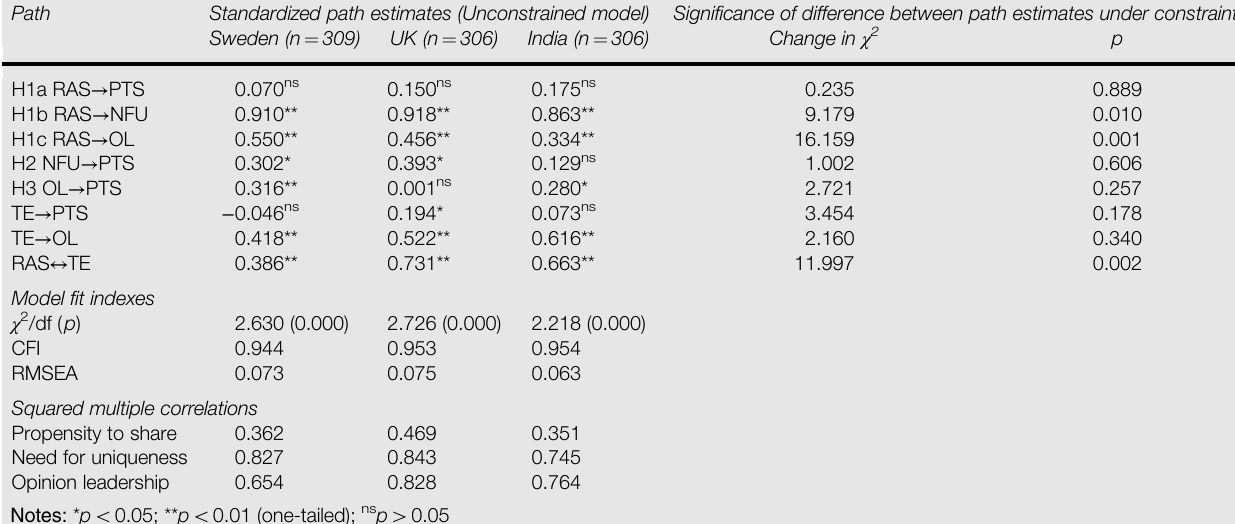
Table III Multigroup analysis – countries